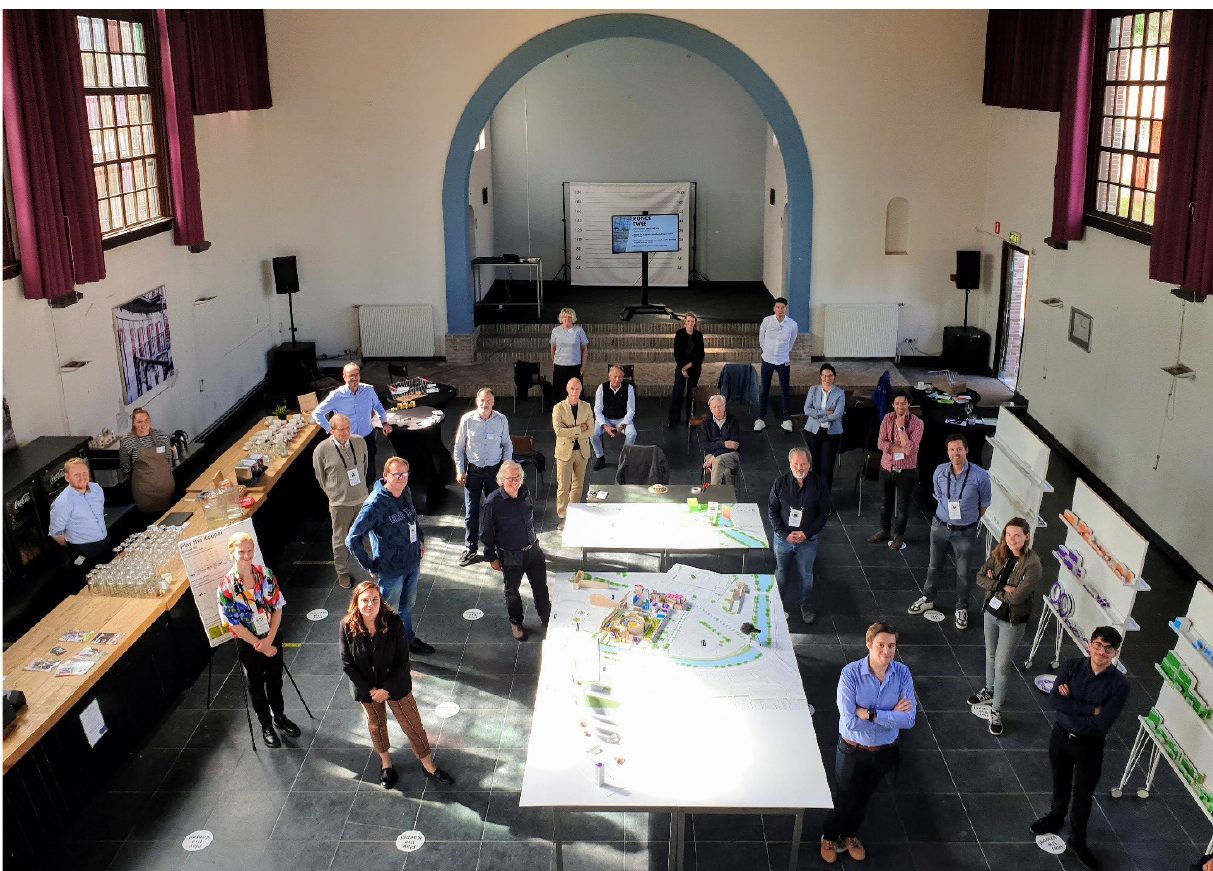
Figure 10. Photo taken during a play session of Play the Koepel in